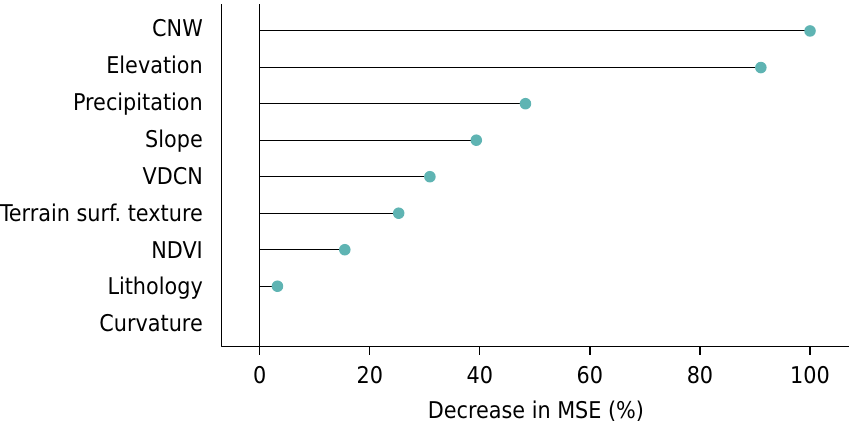
Figure 8. Importance of covariates in soil mapping by Multinomial Logistic Regression (MLR) classifier.